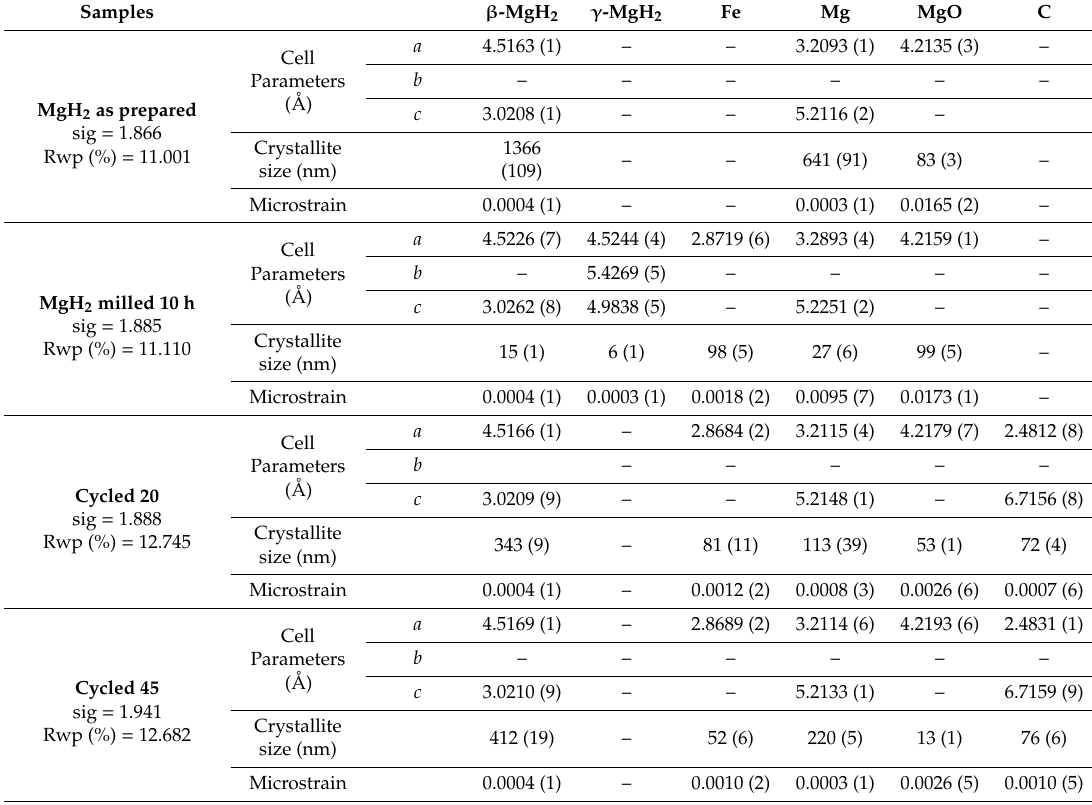
Table 1. Structural refinement parameters of phases present in pristine MgH 2 (as-prepared), ball milled MgH 2 , MgH 2 –5Fe–5ENG after 20 and 45 cycles, obtained by Rietveld refinement.